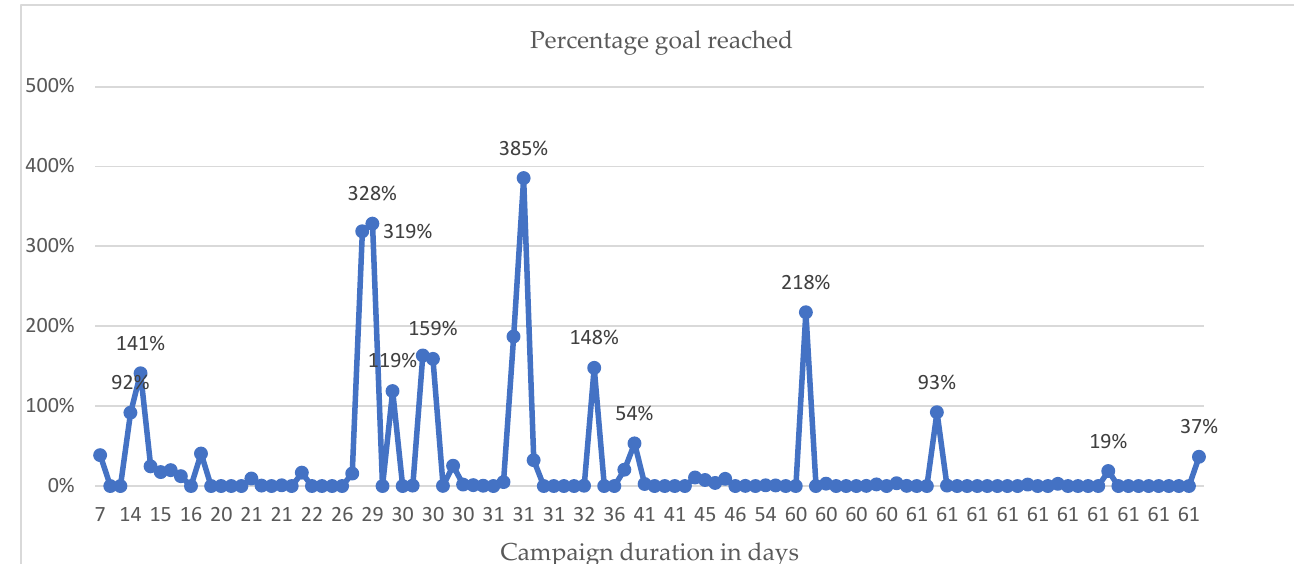
Figure 5. Duration of Crowdfunding Campaign. Source: Authors’ own compilation.